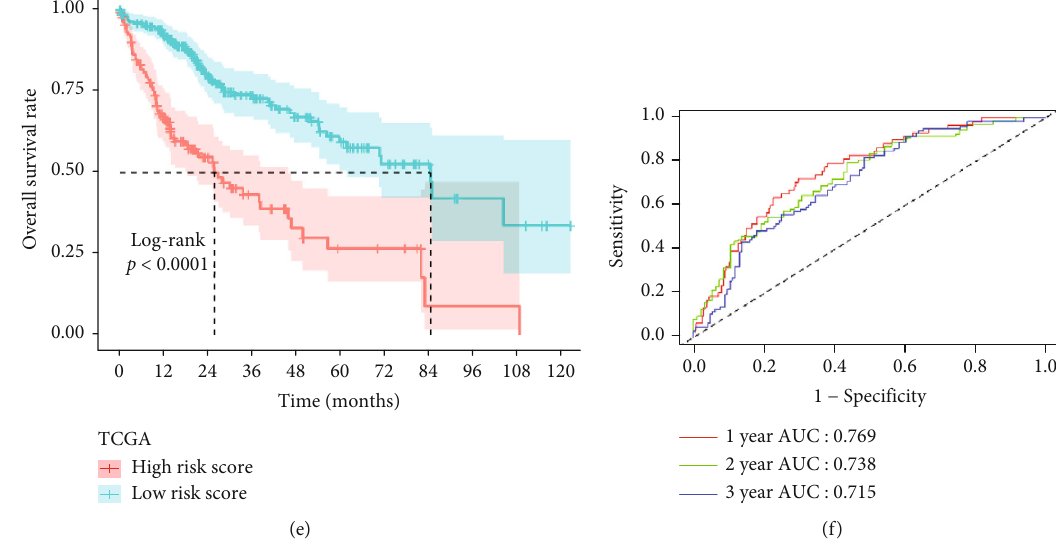
Figure 2: Development and survival examinations of four-gene signature in TCGA. (a) Identi fi cation of overlapping prognostic ERSRGs in TCGA, ICGC, and GSE14520 datasets. (b) Enrichment analysis of 28 overlapping prognostic ERSRGs. (c) The parameter selection in the LASSO-Cox analysis was adjusted by 10 cross-validations. (d) Distribution of risk scores, OS status, and gene expression pro fi les. (e) Kaplan-Meier survival plot. (f) Characteristics of predicted 1-, 2-, and 3-year OS rates in ROC